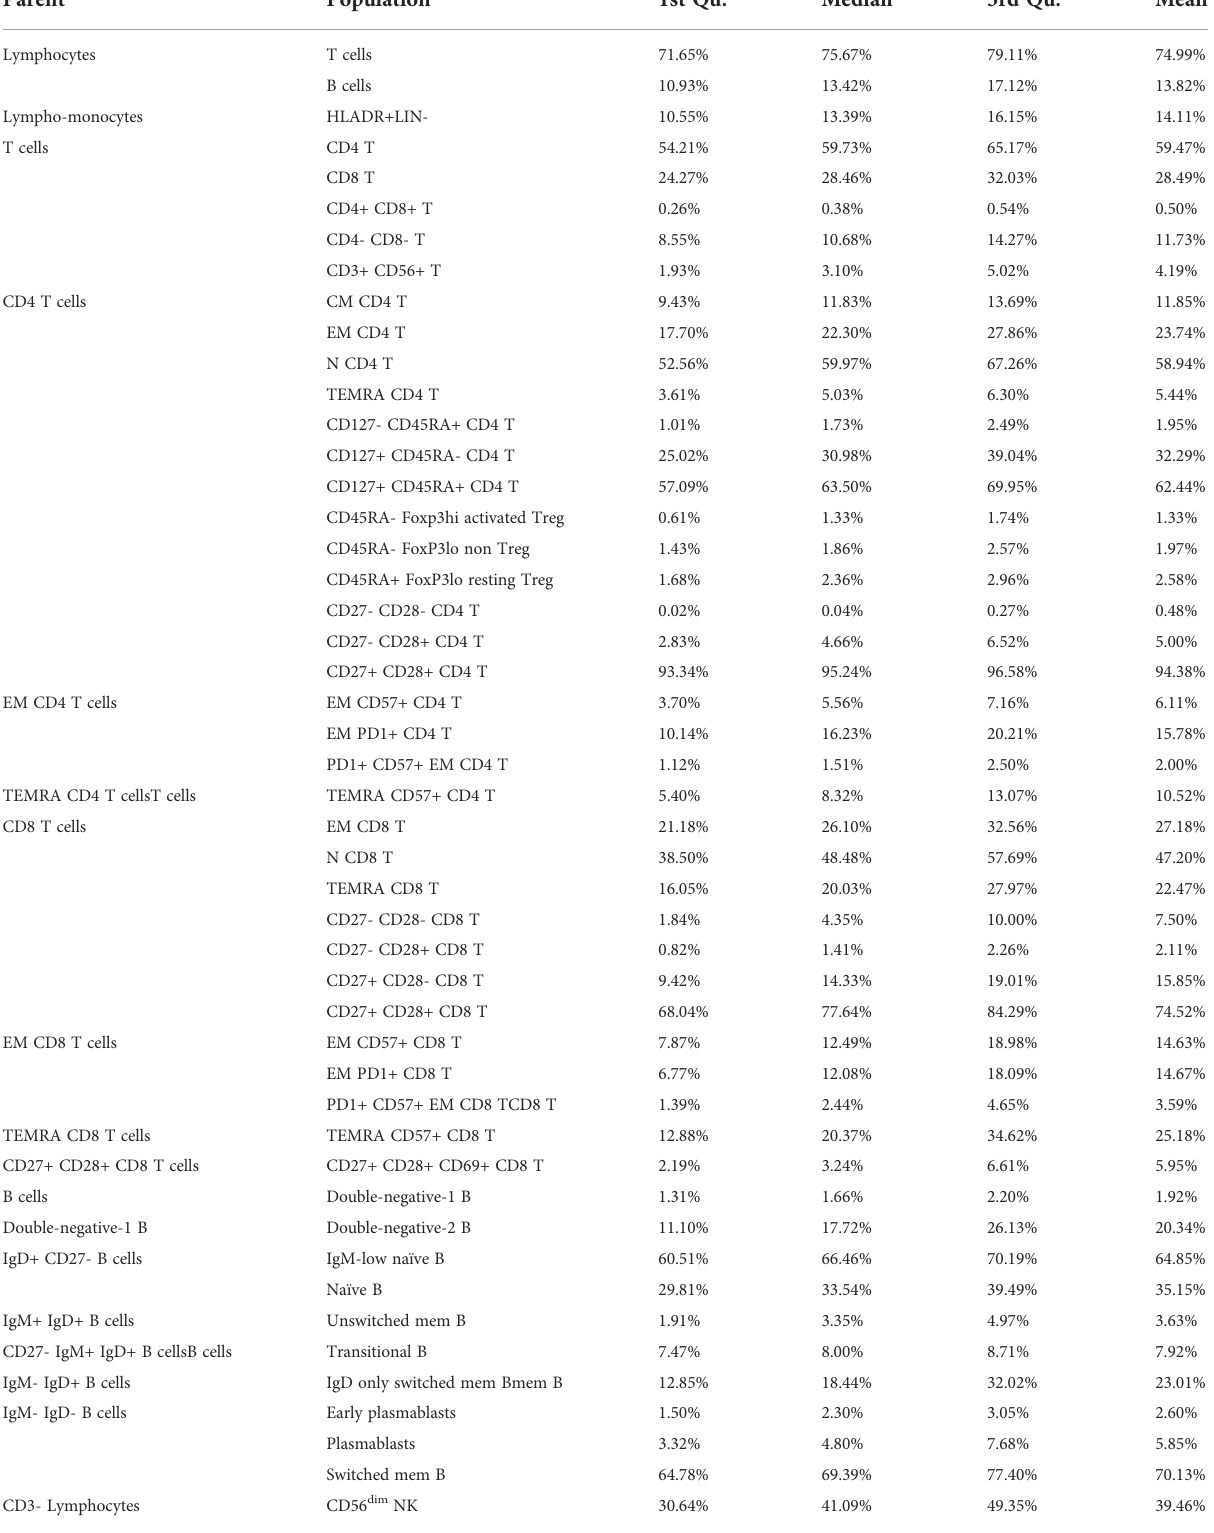
TABLE 2 Cell frequencies in healthy